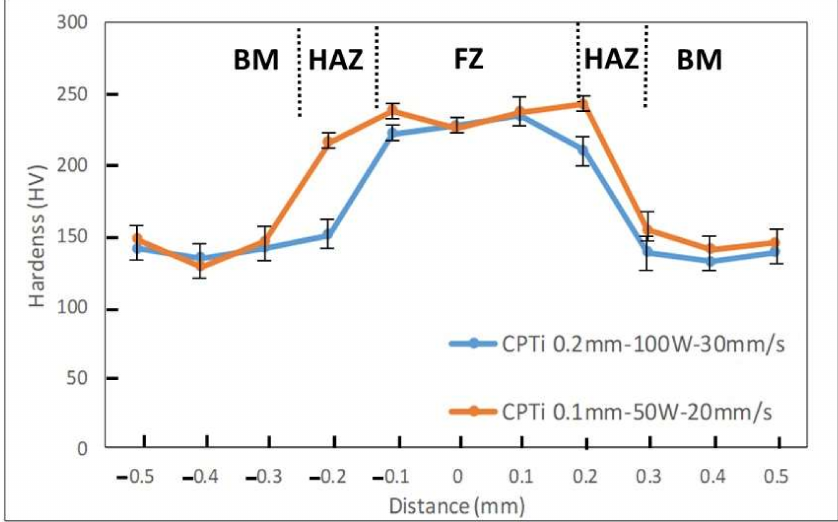
Figure 7. Hardness profiles of the welded samples for two different